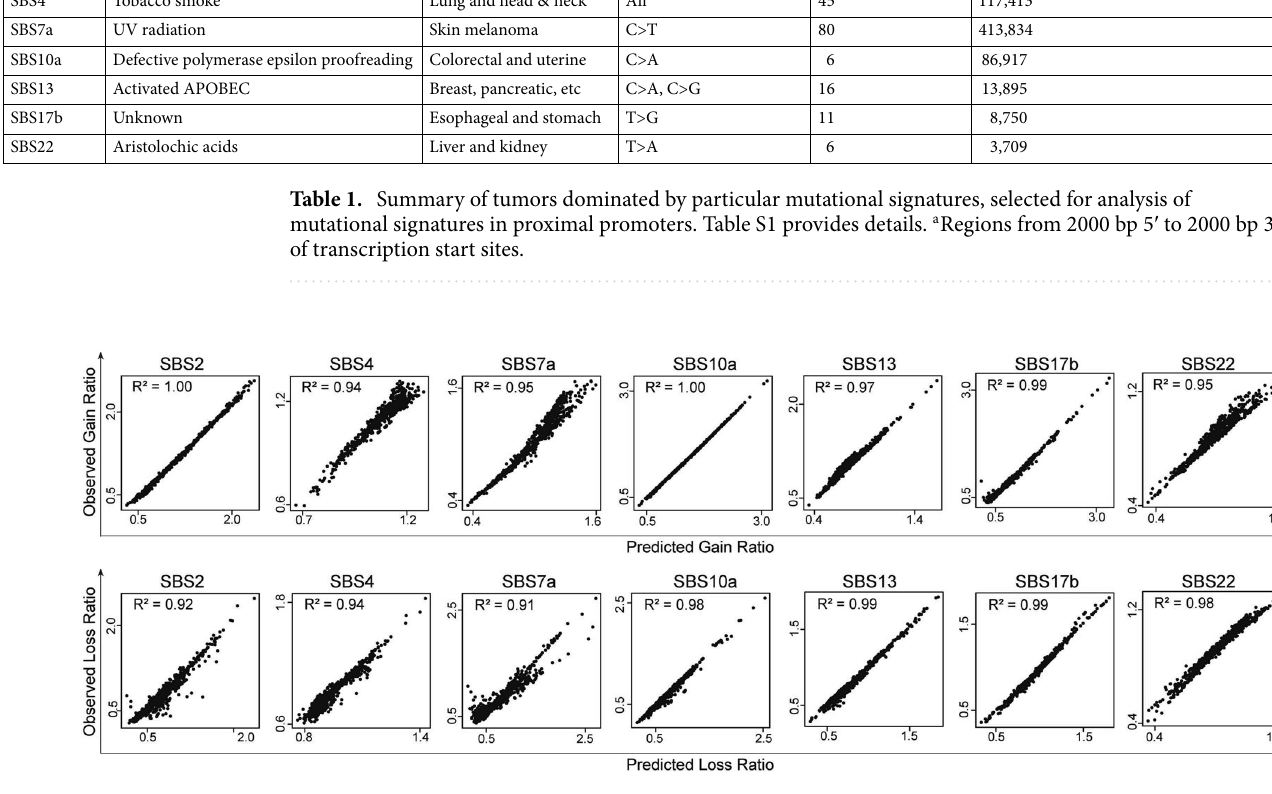
Figure 2. Gain and loss ratios based on the frequencies of mutations in the signatures were similar to gain and loss ratios based on actual promoter mutations observed in tumors with mutations dominated by a particular signature. Each dot corresponds to a PBM experiment for one